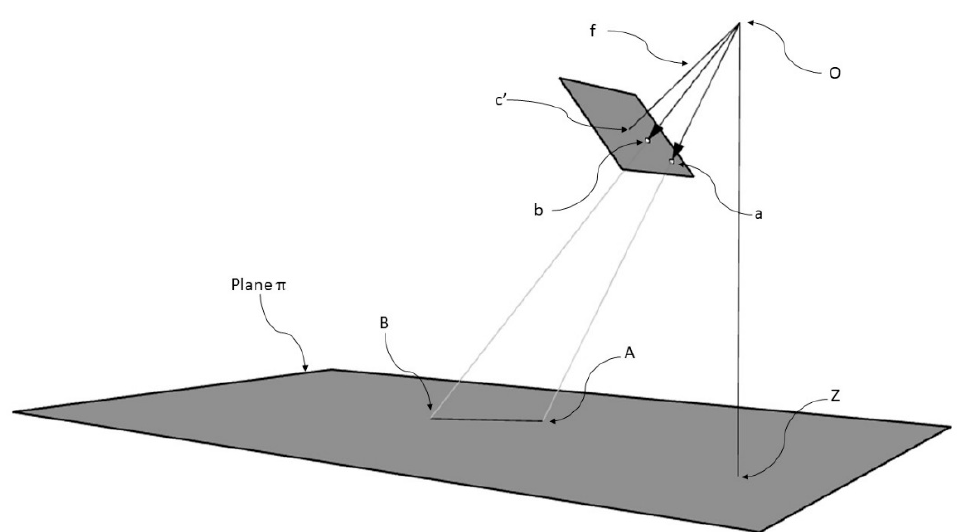
Figure 4. Graphical representation of the parameters involved for the calculation of the height of the camera from the plane π . The description of the parameters is given in the text. (Source: personal collection).